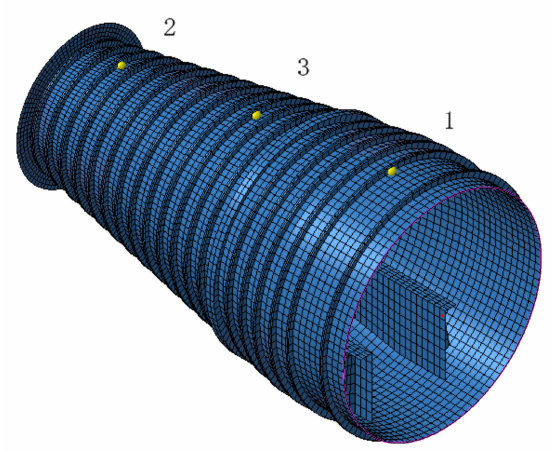
Figure 4. Three monitoring points on the